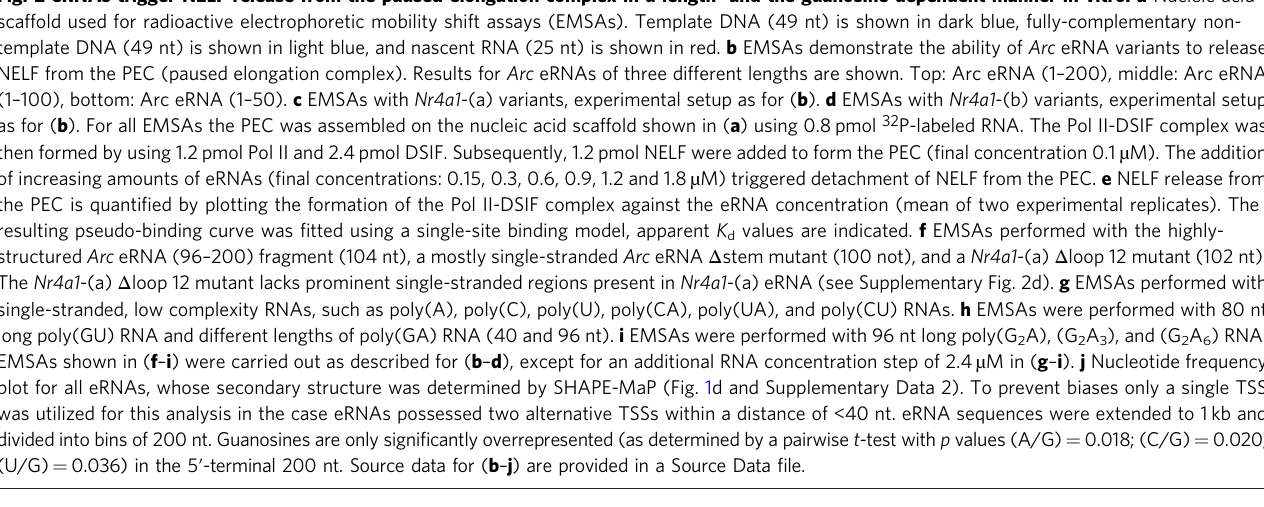
Fig. 2 eRNAs trigger NELF release from the paused elongation complex in a length- and the guanosine-dependent manner in vitro. a Nucleic acid scaffold used for radioactive electrophoretic mobility shift assays (EMSAs). Template DNA (49 nt) is shown in dark blue, fully-complementary non- template DNA (49 nt) is shown in light blue, and nascent RNA (25 nt) is shown in red. b EMSAs demonstrate the ability of Arc eRNA variants to release NELF from the PEC (paused elongation complex). Results for Arc eRNAs of three different lengths are shown. Top: Arc eRNA (1 – 200), middle: Arc eRNA (1 – 100), bottom: Arc eRNA (1 – 50). c EMSAs with Nr4a1 -(a) variants, experimental setup as for ( b ). d EMSAs with Nr4a1 -(b) variants, experimental setup as for ( b ). For all EMSAs the PEC was assembled on the nucleic acid scaffold shown in ( a ) using 0.8 pmol 32 P-labeled RNA. The Pol II-DSIF complex was then formed by using 1.2 pmol Pol II and 2.4 pmol DSIF. Subsequently, 1.2 pmol NELF were added to form the PEC ( fi nal concentration 0.1 µ M). The